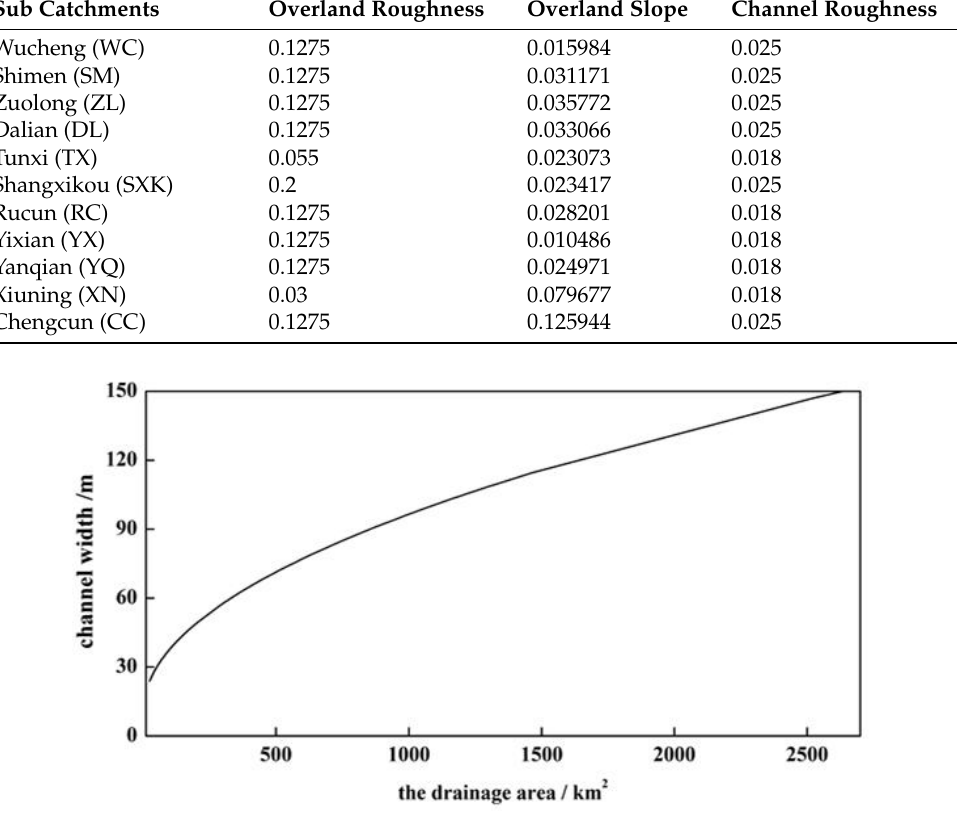
Figure 5. Relationship between river width and upstream drainage area in Tunxi